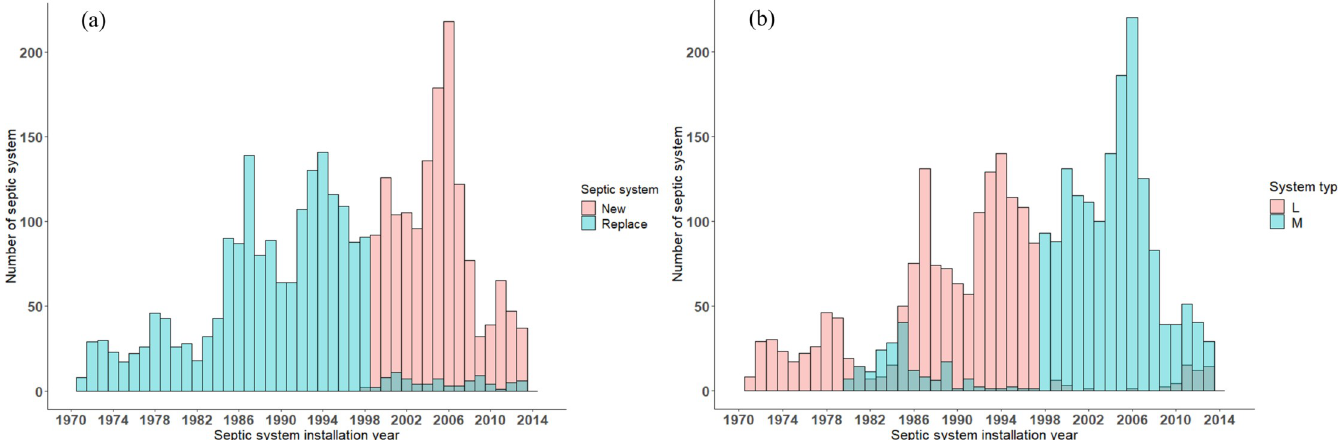
Fig 6. Bar graphs of the number of septic systems’ New or Replace (a), and Mounded ( M ) vs. Level ( L ) septic system drainfields (b), as a function of septic system installation year for revised inspection report in the southern part of Bryan County, Georgia.